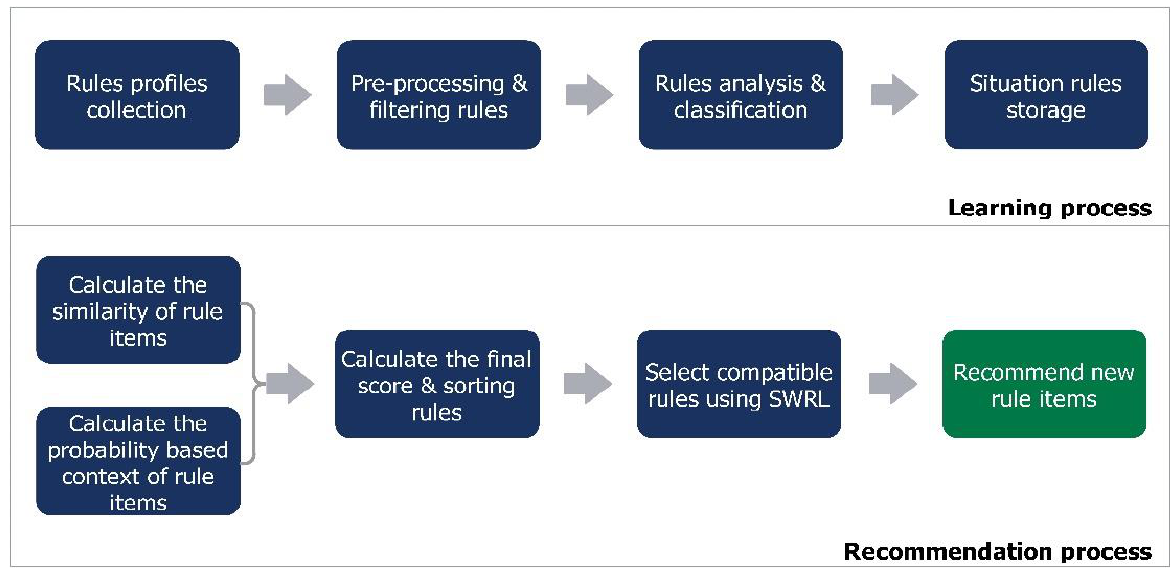
Figure 2. General architecture of the framework.